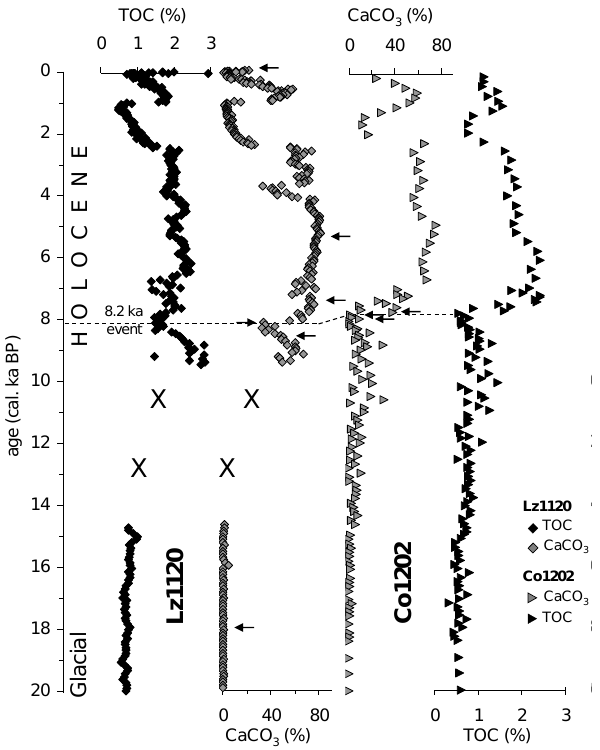
Fig. 2. Weight percentages of carbonate (CaCO 3 ) and total organic carbon (TOC) of Lz1120 and Co1202 (X = hiatus in sediments from site Lz1120; data from Wagner et al., 2009). Black arrows mark the samples selected for this study. Although the current stratigraphic model of site Co1202 suggests a lag of the early Holocene minima occurring in both proxies around 7.8ka relative to similar minima observed around 8.2ka at site Lz1120 we are confident that these are corresponding features and represent the prominent 8.2ka cool- ing